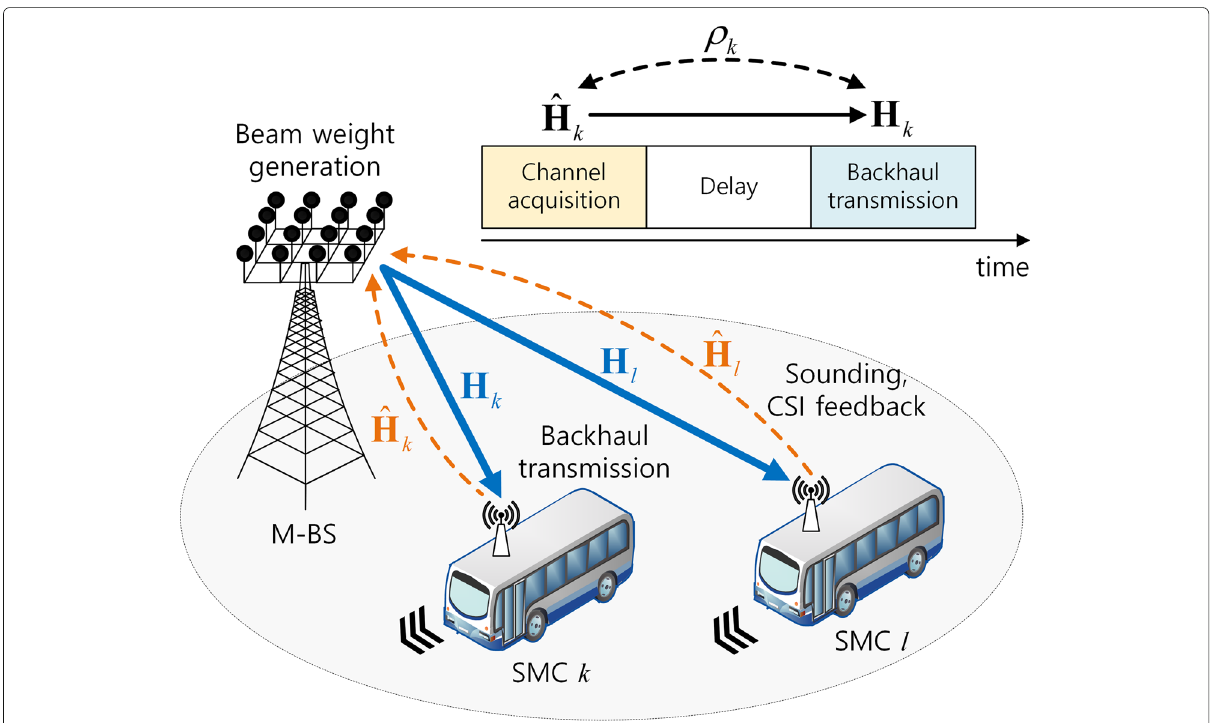
Fig. 1 A cellular system with